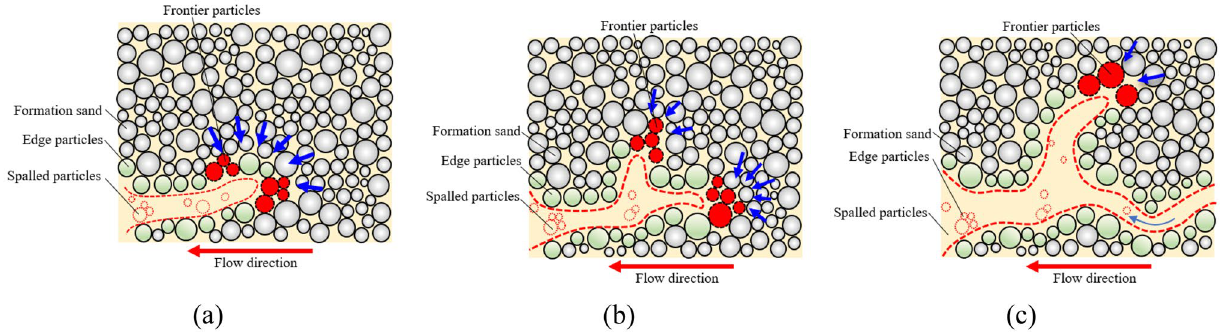
Fig. 15 Schematic diagram of the cavity concurrent extension mecha- nism of the MBW. a Concurrent detachment of weakly-cemented surfaces at the front of the wormhole pattern; b the branches of the